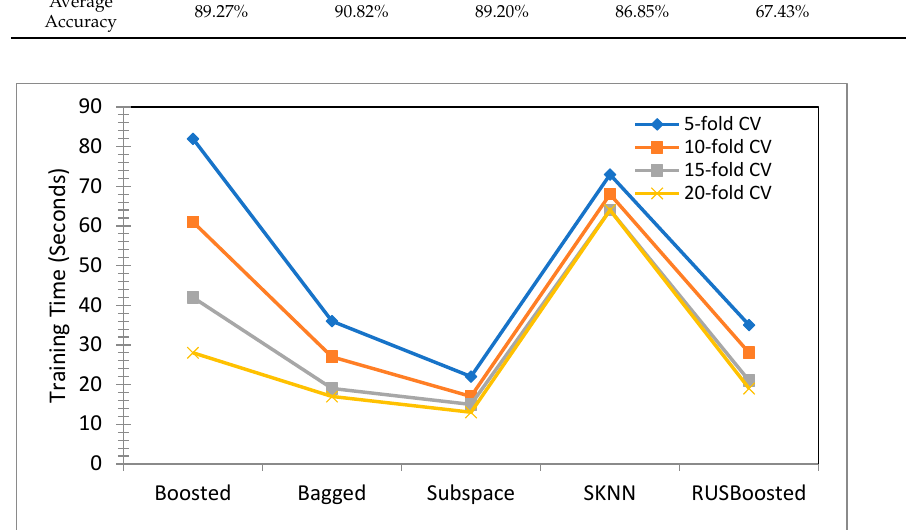
Table 6. Effect of number of learners on various validation parameters .